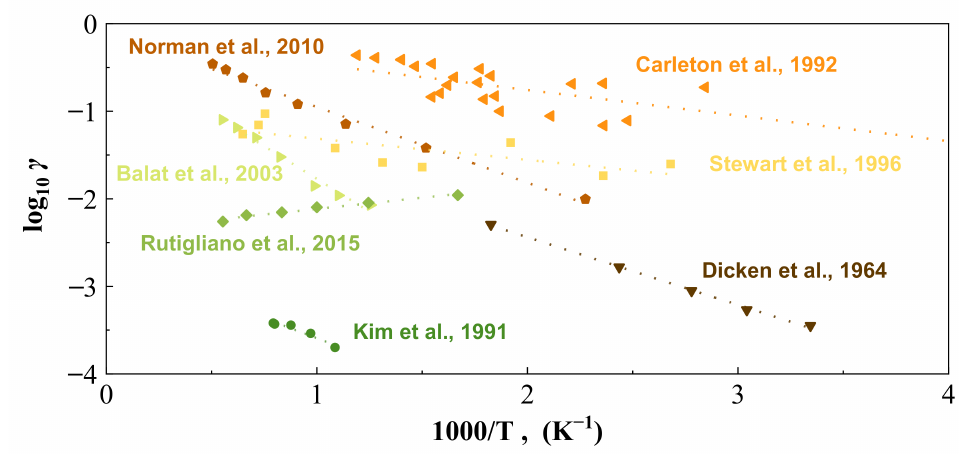
Figure 1. Typical silica surface catalysis recombination coefficient measurement values